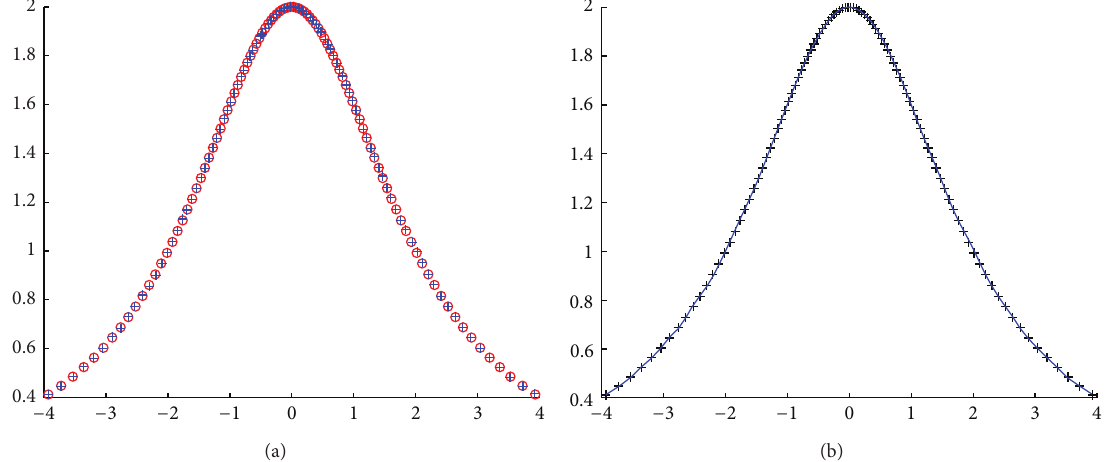
Figure 1: Application of the cuckoo search algorithm to the Agnesi curve: (a) original data points (red emptied circles) and reconstructed points (in blue plus symbol); (b) data points (black plus symbol) and fitting curve (solid blue line).